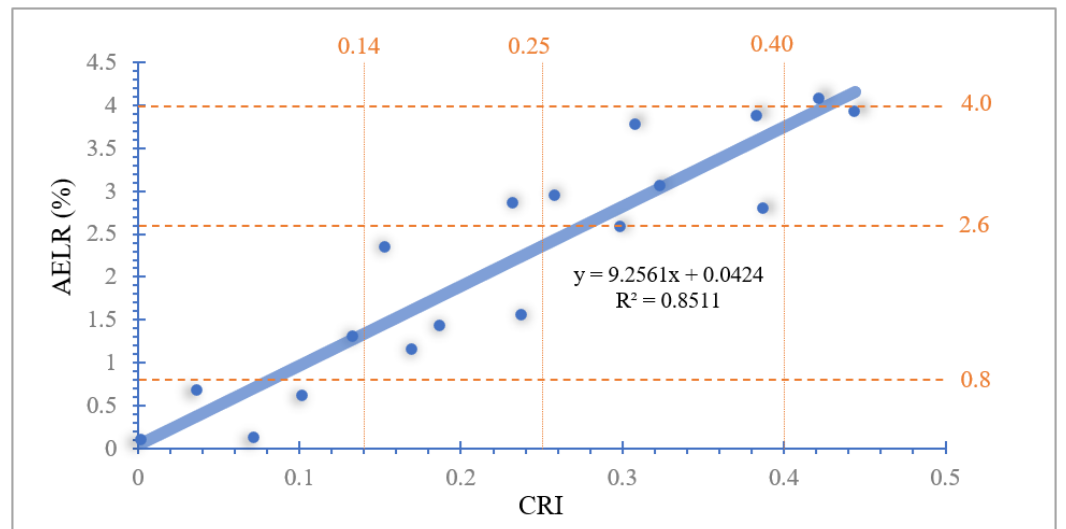
Table 4. Distribution of flash flood CRI intervals and the AELR intervals in Weifang.